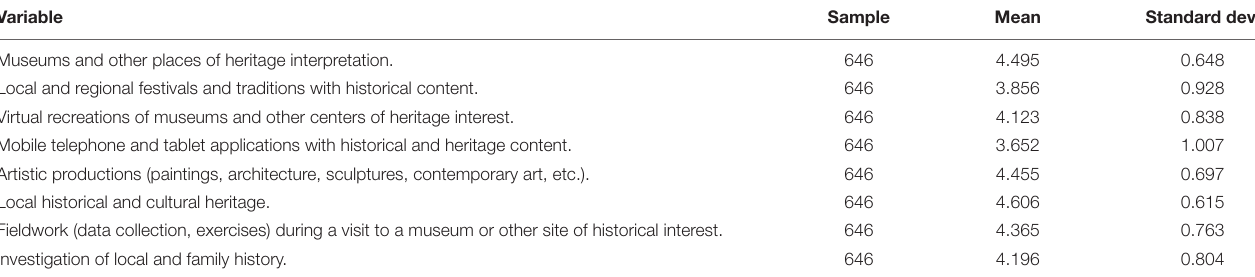
FIGURE 2 | Biplot graph of the EFA of Set II.3. TABLE 5 | Agglomerative hierarchical clustering of the items related with heritage. Variable Sample Mean Standard